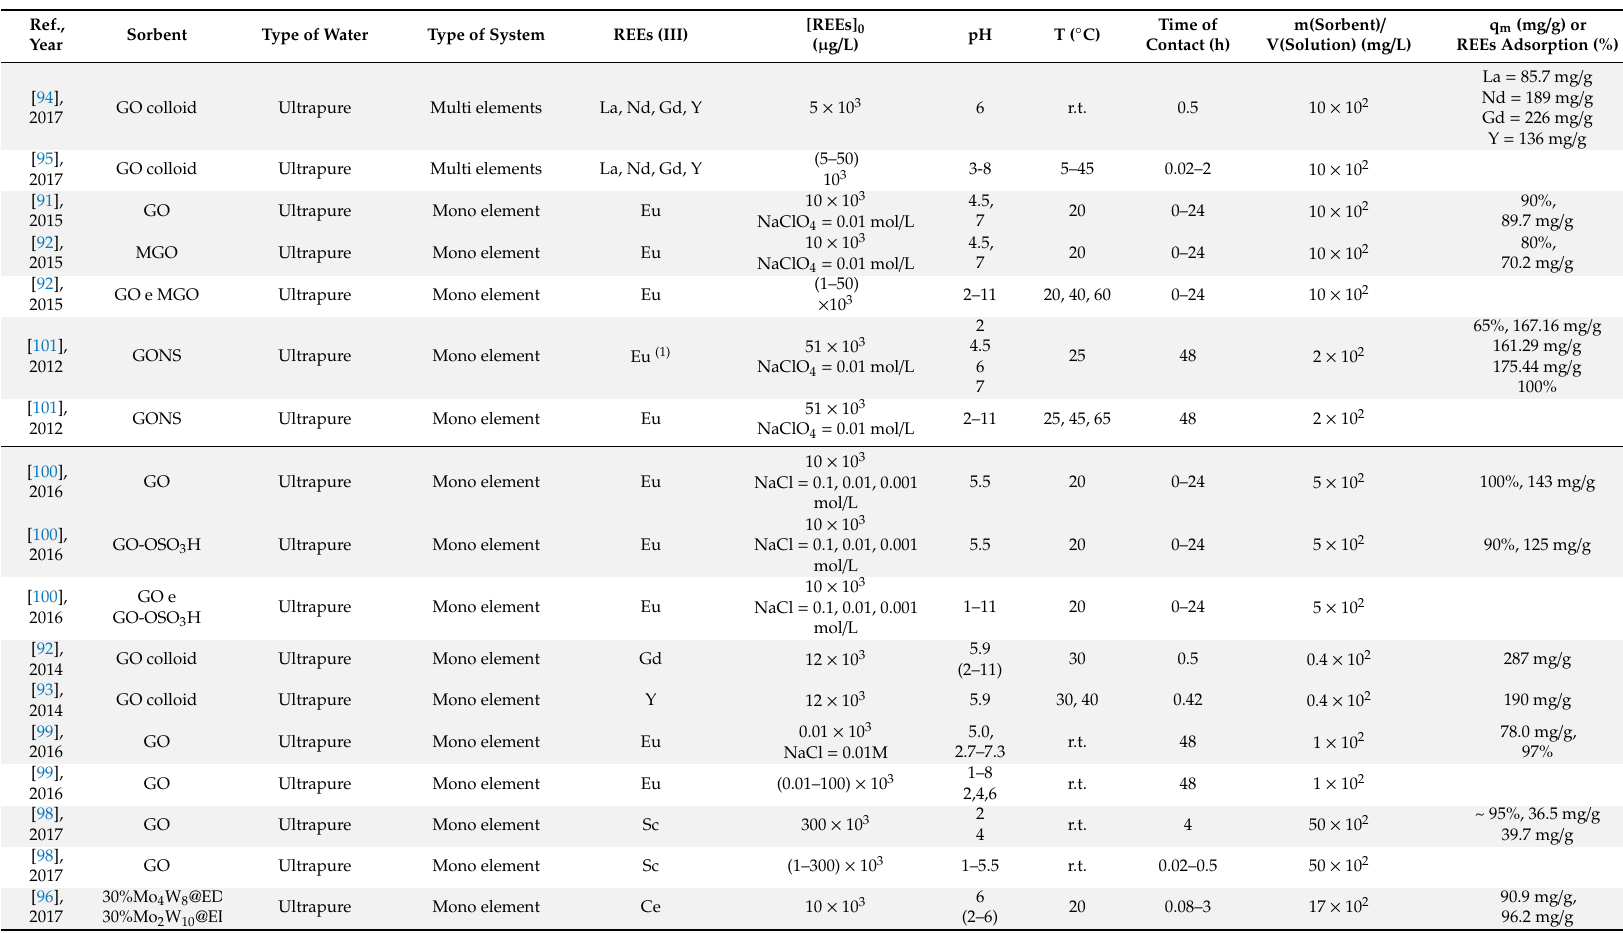
Table 5. Recovery of REEs using Graphene oxide (GO) composites and the respectively experimental conditions used as reported in the literature. Ref.,